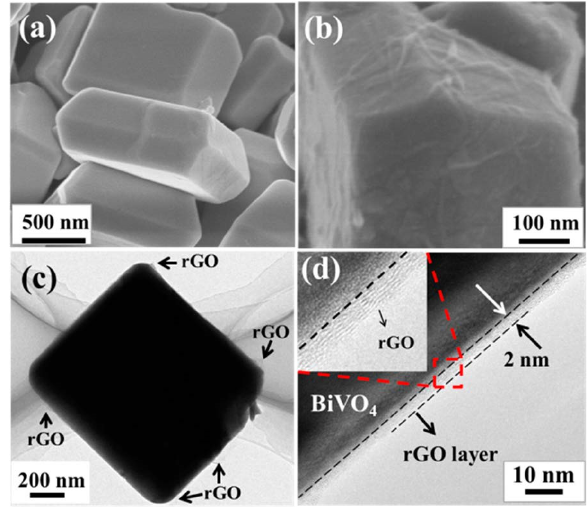
Figure 7. SEM images of as-synthesized samples: ( a ) BiVO 4 with smooth surface; ( b ) rGO/BiVO 4 with rGO layer uniformly attached on BiVO 4 forming a wrinkled surface, and ( c , d ) TEM images of rGO/BiVO 4 exhibiting a tight contact between BiVO 4 and the rGO layer (about 2 nm). Reprinted with permission from [42]. Copyright (2014) ACS.